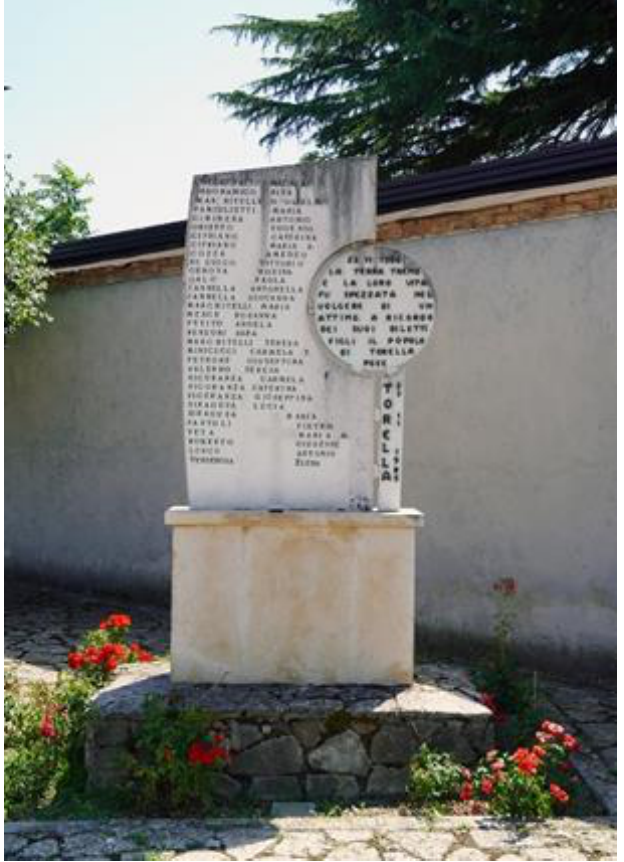
Figure 77. Torella dei Lombardi: stone plaque to remember the victims of the 1980 earthquake (photos by